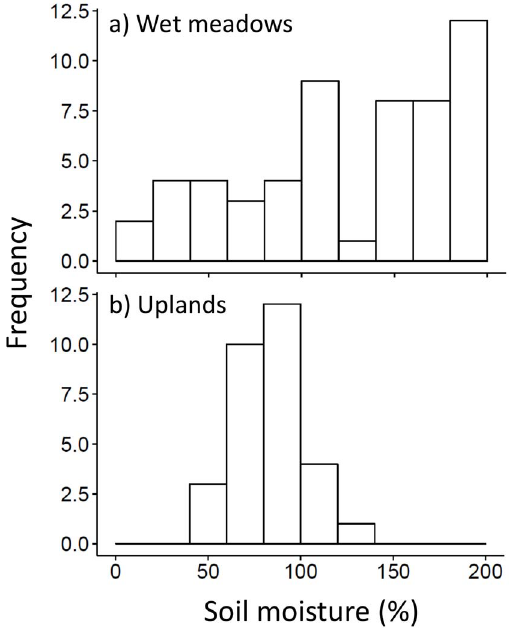
Figure 2. Histograms for end-of-season cumulative soil mois- ture according to ungrazed grassland habitat type: a) wet meadows and b) uplands. Wet meadow grasslands were sampled in 2011 and upland grasslands in